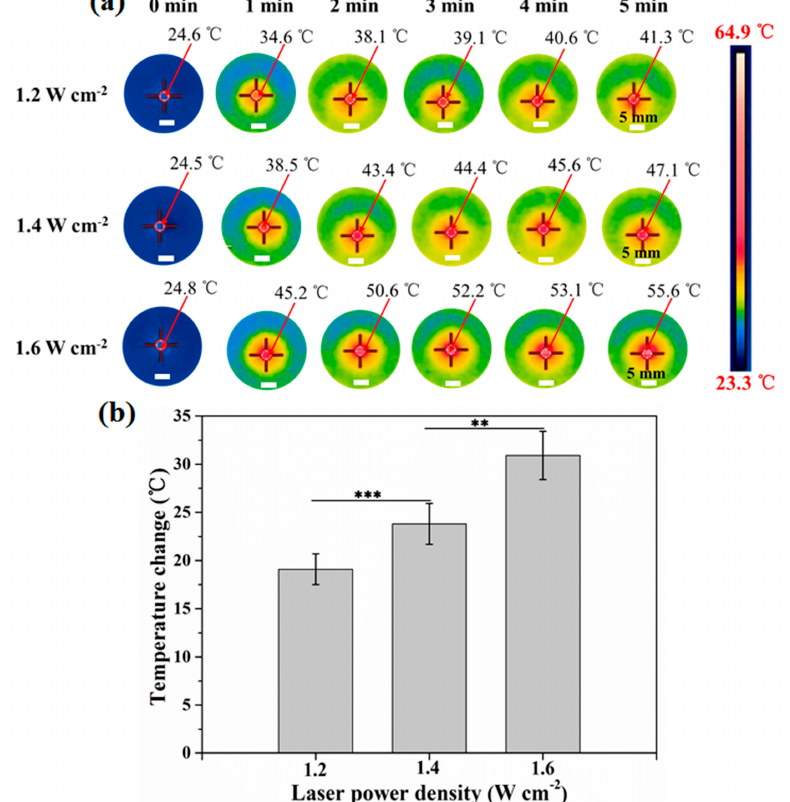
Figure 2. Real-time infrared thermal images of AuNRs–gelatin composite scaffold under 805 nm laser irradiation at various power densities of 1.2, 1.4 and 1.6 W cm − 2 for 0–5 min ( a ); and temperature change of the AuNRs–gelatin composite scaffold after being irradiated at various laser power densities for 5 min ( b ). The data represent the means ± S.D. (n = 3). Significant difference: ** p < 0.01; *** p < 0.001.